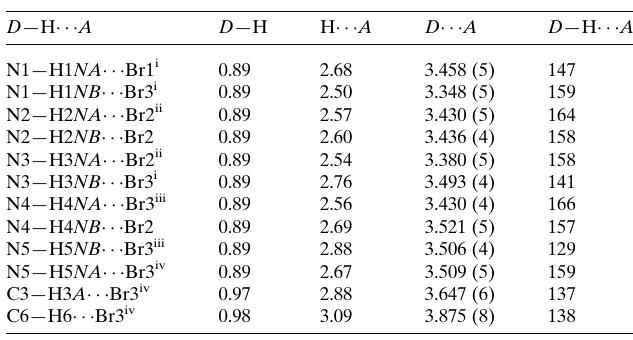
Table 1 Hydrogen-bond geometry (A˚ , (cid:5) ).